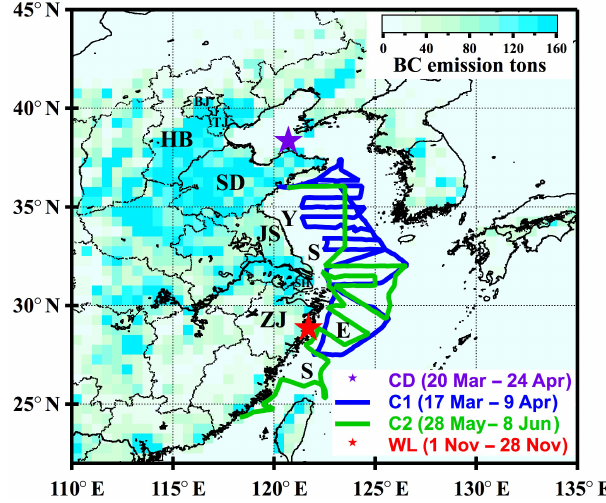
Figure 1. The coastal sites, cruise tracks, and their observation periods for the campaigns conducted in 2011. The purple star is the coastal site of Changdao Island (CD), and the red star is the coastal one of Wenling (WL). The blue line is the track of the first cruise (C1) and the green line is the track of the second cruise. The yearly mean anthropogenic emission of BC is also colored on the map (MEIC, http://www.meicmodel.org). Abbreviations